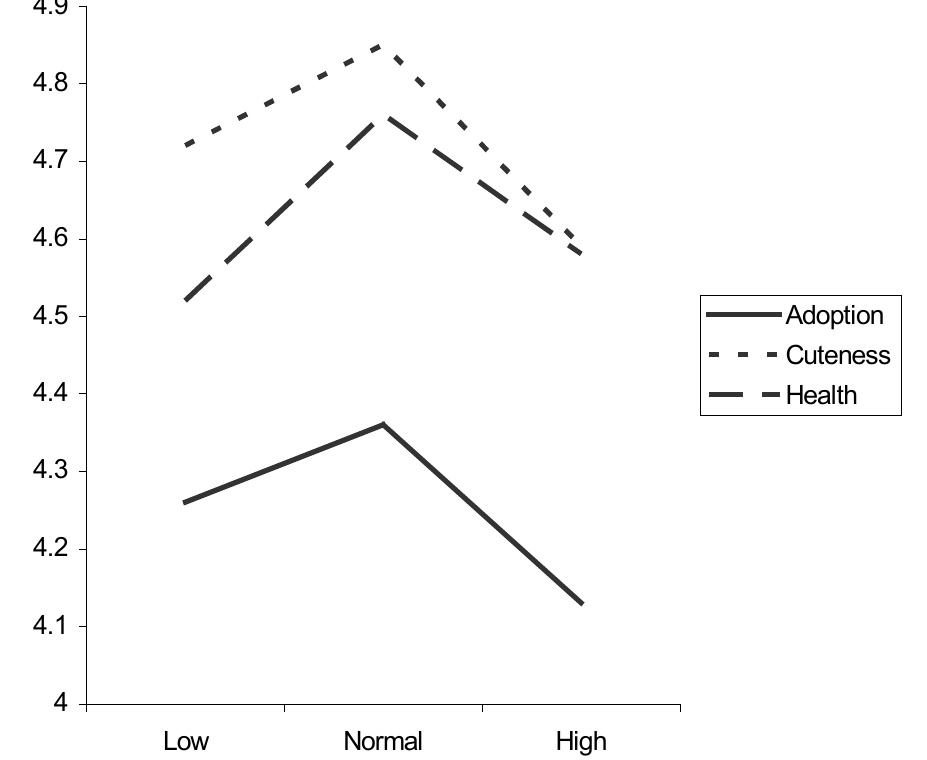
FIGURE 2 . Average ratings of adoption preference, cuteness, and health for the low, normal, and high body weight